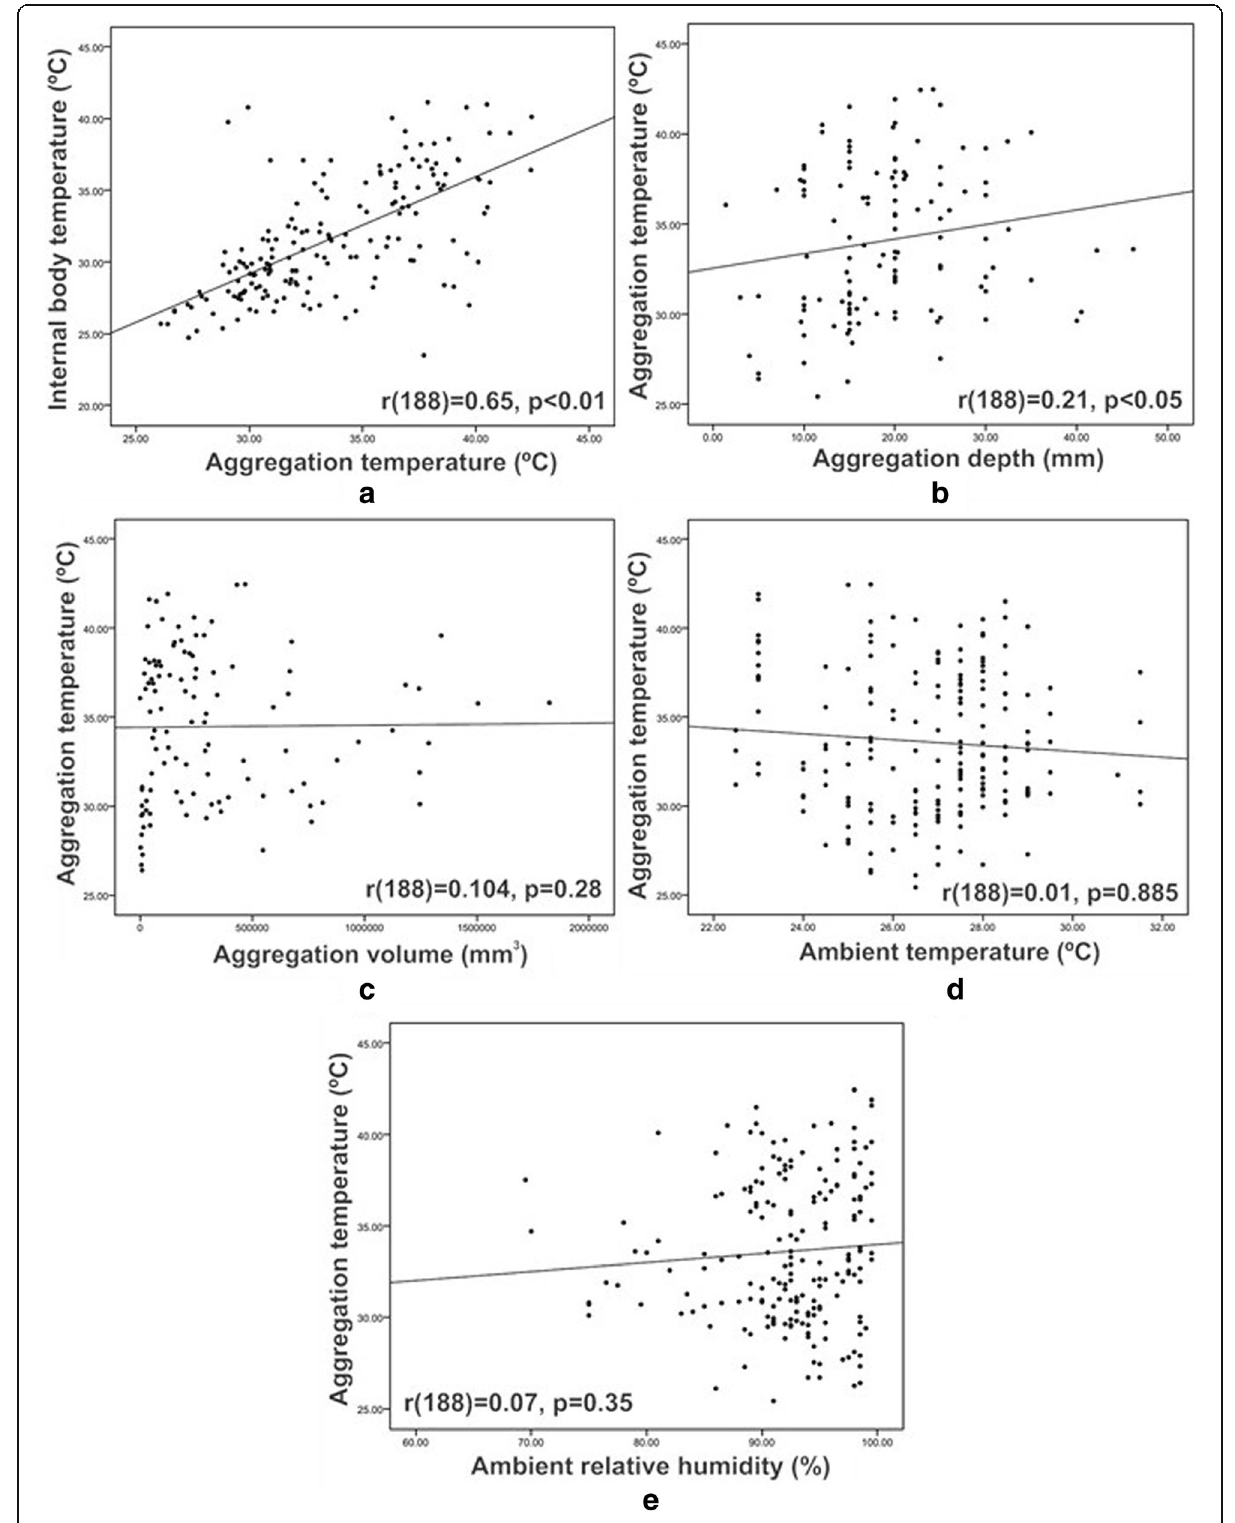
Fig. 3 Scatter plots showing correlation coefficient between blowfly larvae aggregation temperature and physical and environmental factors regardless of location and species. a Aggregation temperature against internal carcass temperature. b Aggregation depth against aggregation temperature c Aggregation volume against aggregation temperature d Ambient temperature against aggregation temperature e Ambient relative humidity against aggregation